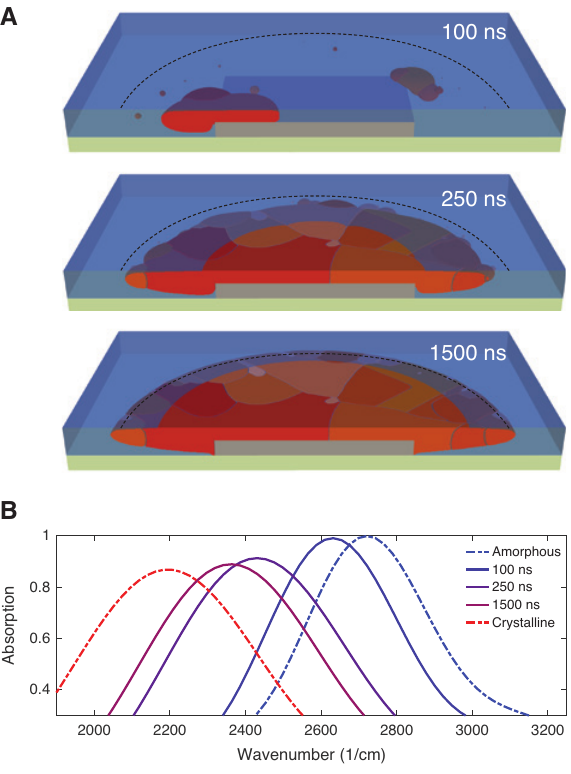
Figure 2: Multiphysics description of optical switching. (A) Snapshots of the crystallization state induced by a Gaussian beam after 100 ns, 150 ns and 1.5 μ s. The buffer layer is shown in green. The square antenna is shown in gray. Blue semi-transparent volume represents the amorphous phase. Other colors code different crystalline phase grains. The superstrate layer is not shown for clarity. The dashed semicircle denotes the waist of the laser beam. (B) Absorption spectrum after 100 ns, 150 ns and 1.5 μ s corresponding to the crystallization states from (A). Dashed-dotted lines correspond to the spectrum of the perfect absorber for a completely amorphous (blue) and crystalline (red) GST